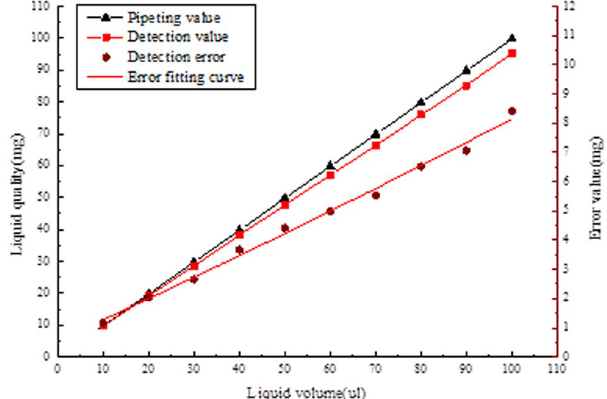
Figure 9. Data graph of slinear stability